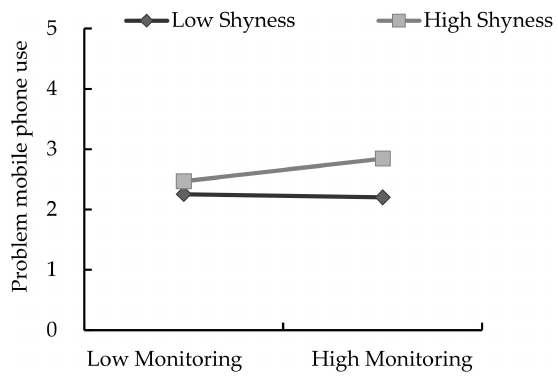
Figure 4. Moderation e ff ect of shyness the relation between parental monitoring and children’s